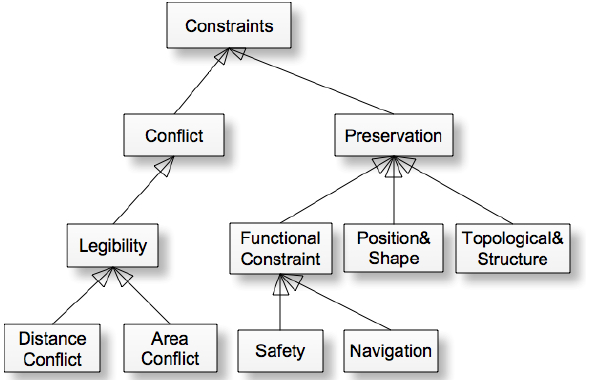
Figure 7: Classification of generalisation constraints. For con- ciseness, most specialised constraints are